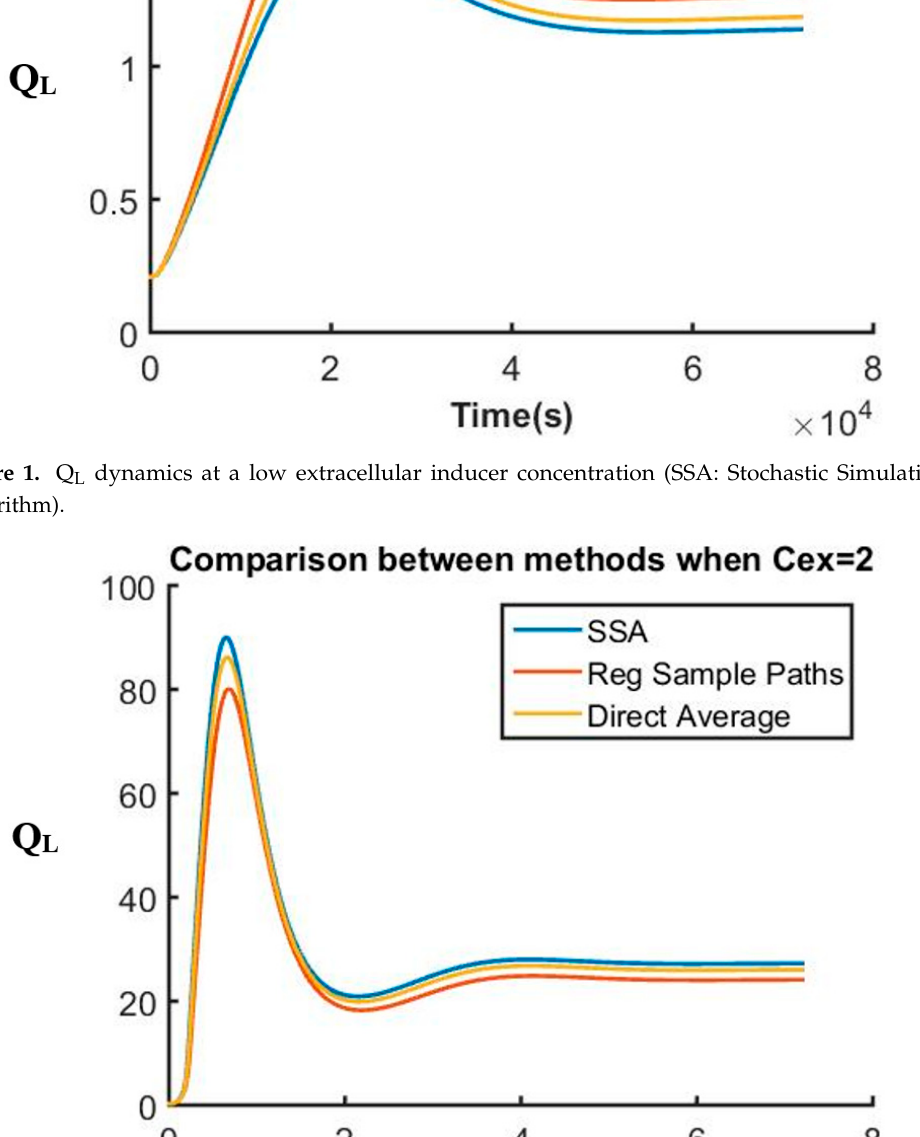
Figure 3. Q L response at various cCF10.